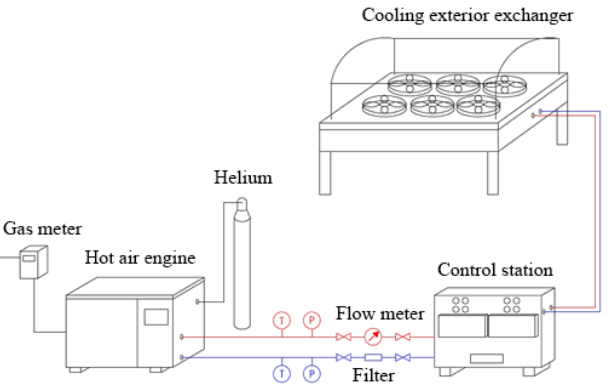
Fig. 1 Measurement